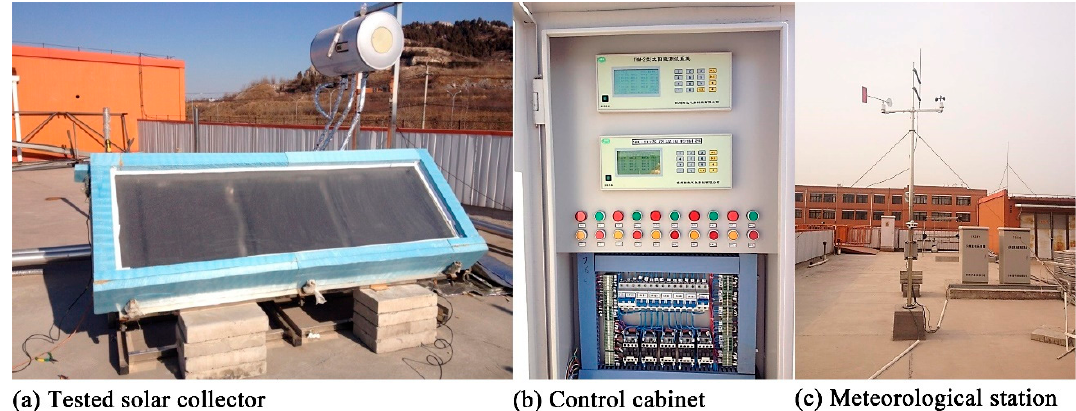
Figure 10. The tested VTBC solar collector and measurement stand.